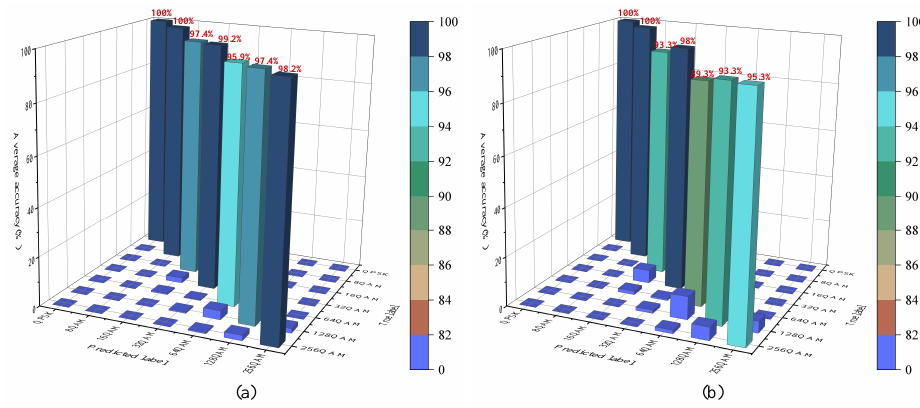
Figure 6. The average identification accuracy after 120 km fiber transmission ( a ) OSNR range is 0 ∼ 30 dB ( b ) OSNR range is 0 ∼ 10 dB.